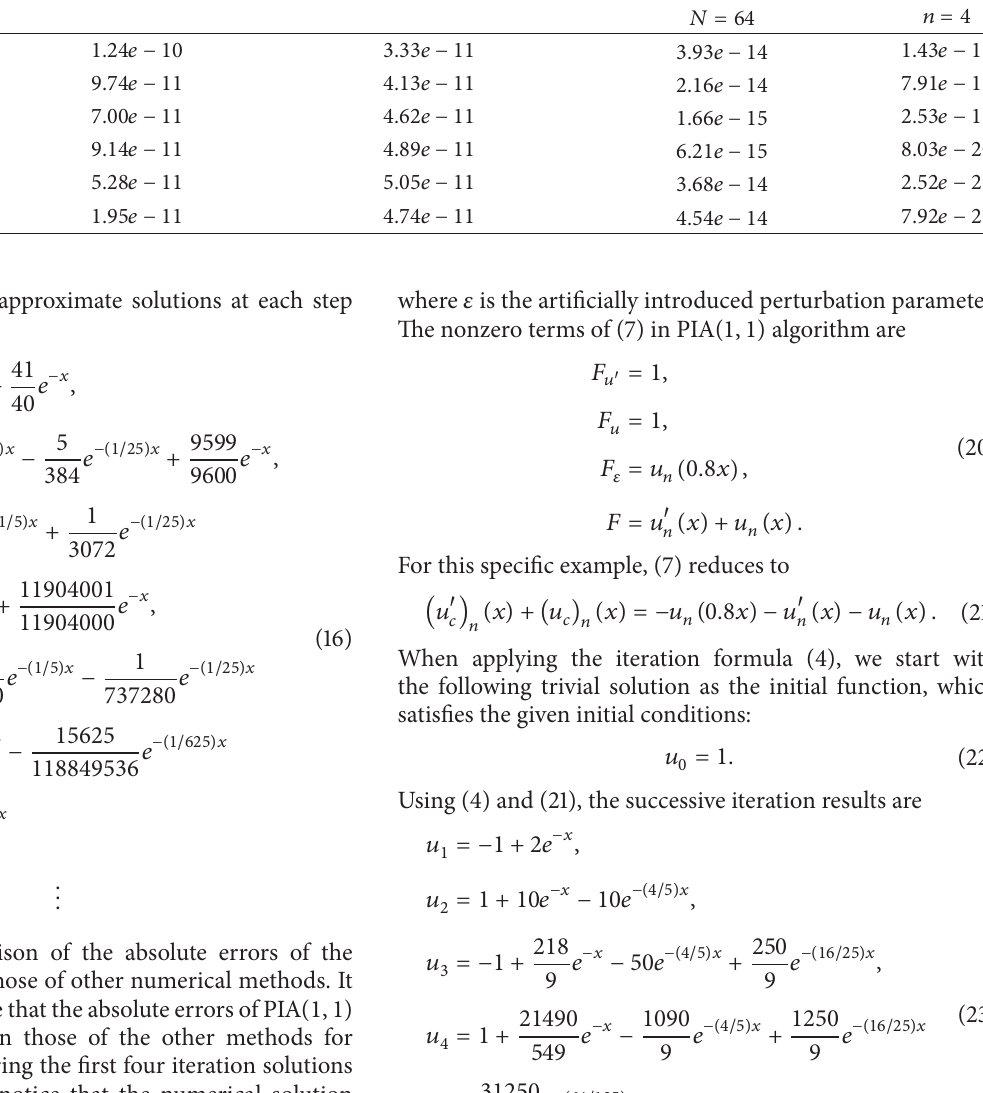
Table 1: Comparison of the absolute errors of the PIA (1,1) method with other numerical methods for example 1 .